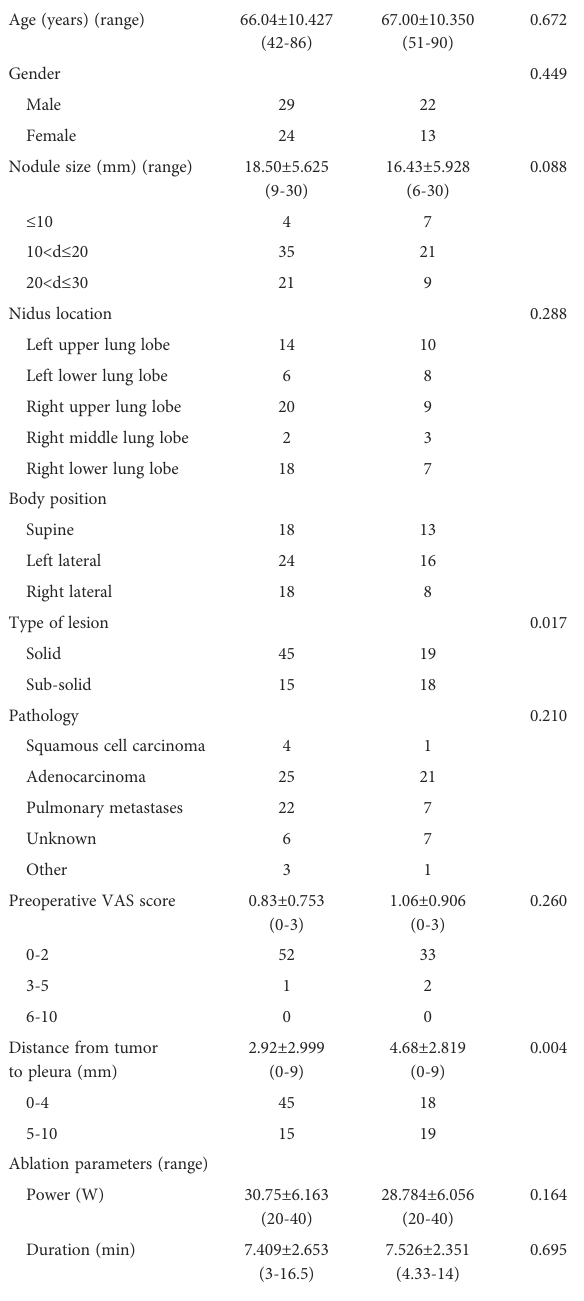
TABLE 1 Patient clinical information and demographics for all